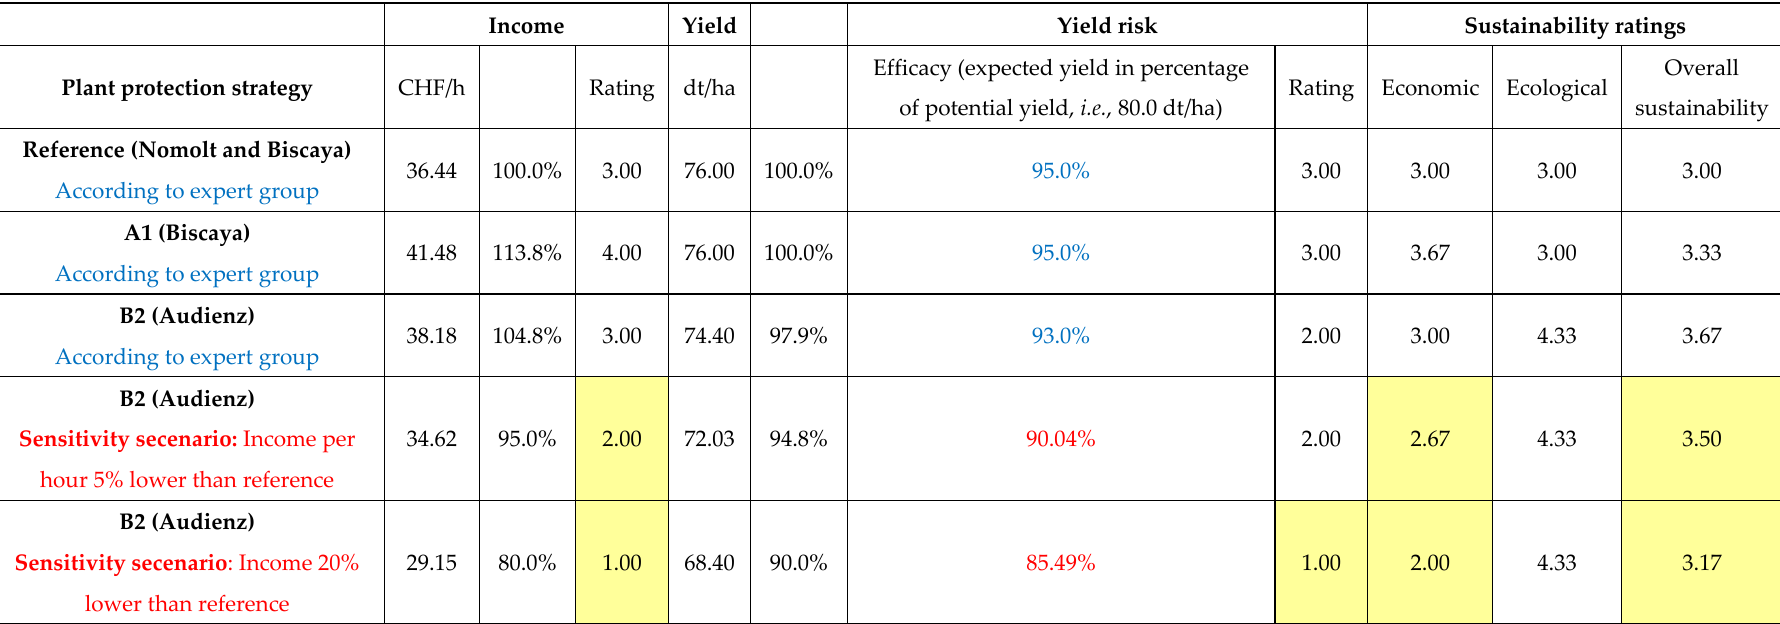
Table 4. Sensitivity analysis of Audienz’s efficacy for the control of the cereal leaf beetle ( Oulema melanopus ) in winter